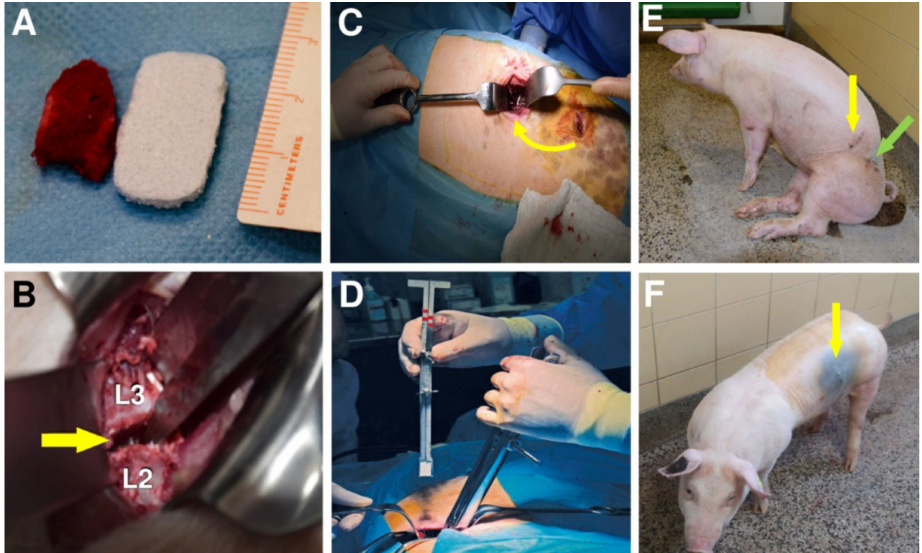
Figure 5. Photograph comparing bone autograft with bioresorbable hybrid implant (BHI) ( A ). Vertebrae L2 and L3 of the lumbar spine, between which the implant was placed ( B ). Iliac crest bone graft implantation (Group A) into L2/L3 segment indicated by an arrow ( C ). Implantation of BHI into L2/L3 segment in Group B using a special implant holder ( D ). A pig after autografting surgery ( E ). Green arrow shows the place where the autograft was withdrawn and yellow arrows the place of implantation. Last photo ( F ) shows a pig with one scar (yellow arrow) after the BHI implantation (Group B).